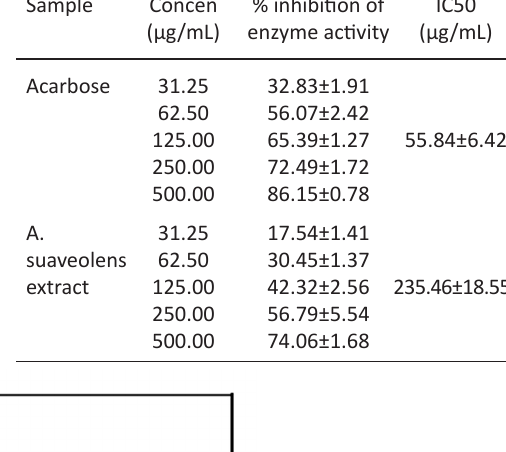
Table 1. Inhibition of α-amylase enzyme activity by A. suaveolens